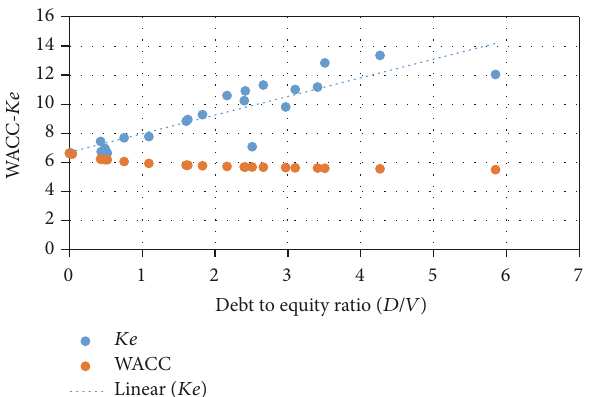
Figure 2: 𝑘 𝑒 and WACC as Function of debt to equity ratio. Source: elaborated by the